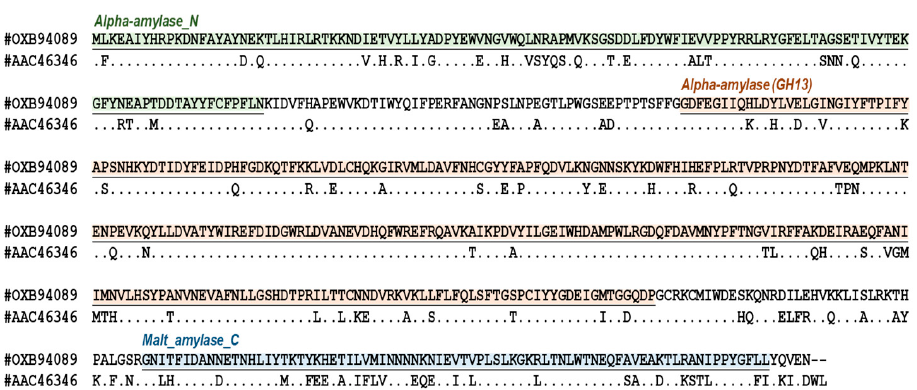
Figure 1. Pg MA (OXB94089) protein sequence. The GH13 family gene sequence identity between Pg MA and BsMT (AAC46346) is 79.08% (465/588). The Pfam domains are as follows: (1) alpha-am-